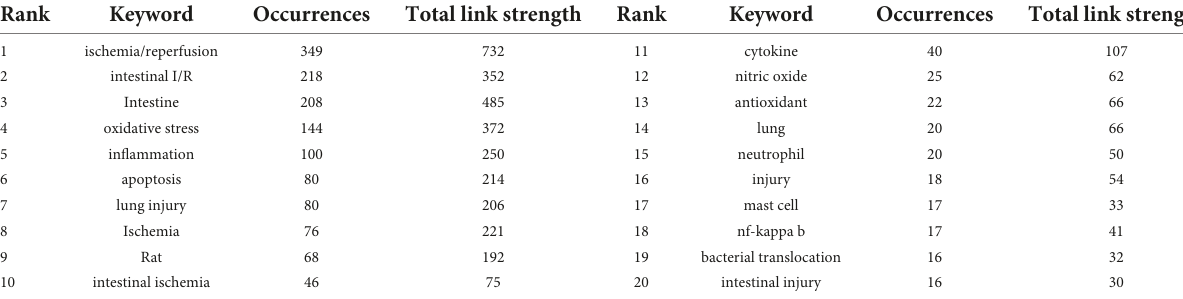
TABLE 6 Top 20 keywords in terms of frequency of